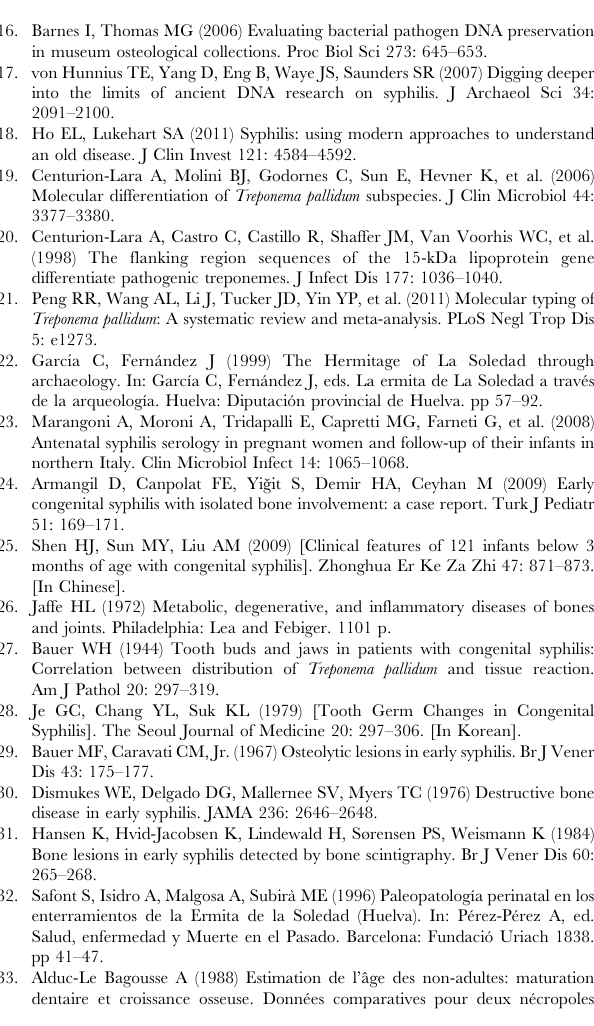
restriction site used to analyze amplifications at the Universitat Auto`noma de Barcelona (Spain). (JPG) Figure S2 5 9 UTR fragment of the 15-kDa lipoprotein gene of Treponema pallidum subspecies pallidum , aligned with clone sequences from samples ELS551 and ELS558, obtained at the University of the Azores (Portugal). A box shows the Eco 47III restriction site, specific to this subspecies. (JPG) Figure S3 5 9 UTR fragment of the 15-kDa lipoprotein gene of Treponema pallidum subspecies pallidum , aligned with clone sequences from samples ELS551, ELS558, and ELS944, obtained at Langebio, CINVES- TAV-IPN (Mexico). A box shows the Eco 47III restriction site, specific to this